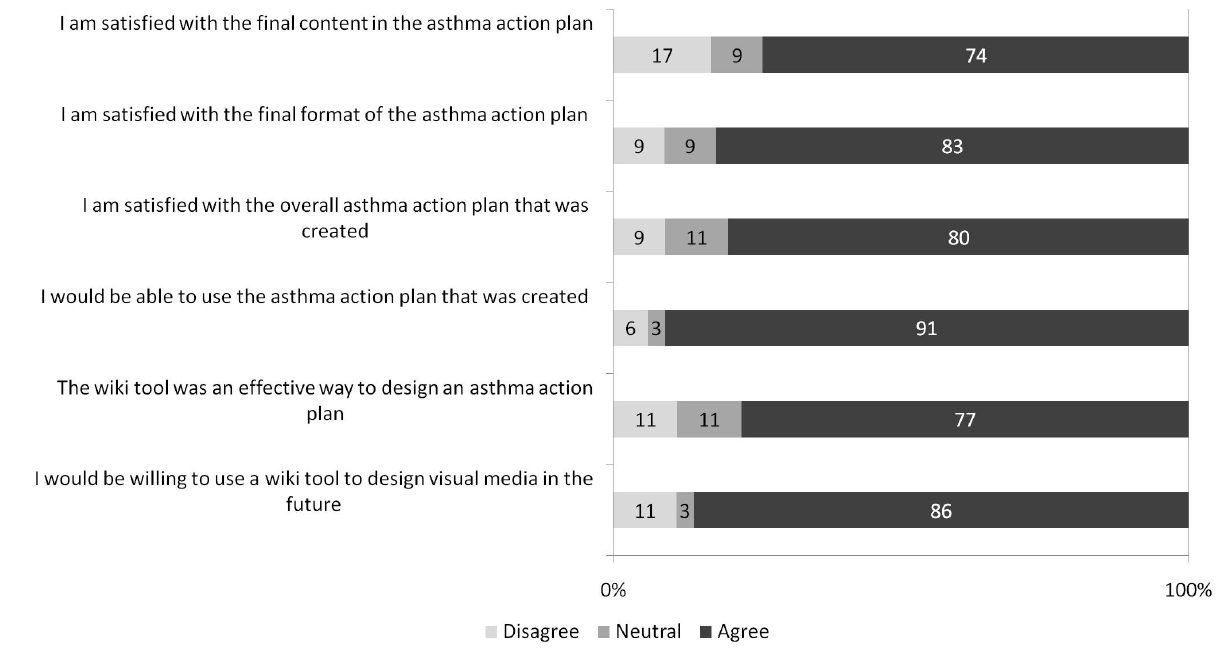
Figure 7. Overall asthma action plan (AAP) and the wiki process. Responses were entered on a 5-point Likert scale labeled as follows: 1, disagree; 3, neutral; and 5, agree. For the purposes of this figure, scores of 1 and 2 were considered “disagree,” and 4 and 5 were considered “agree.” Each bar demonstrates the proportion of participants with each response, for each statement. This includes 35 participants (5 certified asthma educators, 5 primary care physicians, 6 pulmonologists, and 19 patients with asthma).